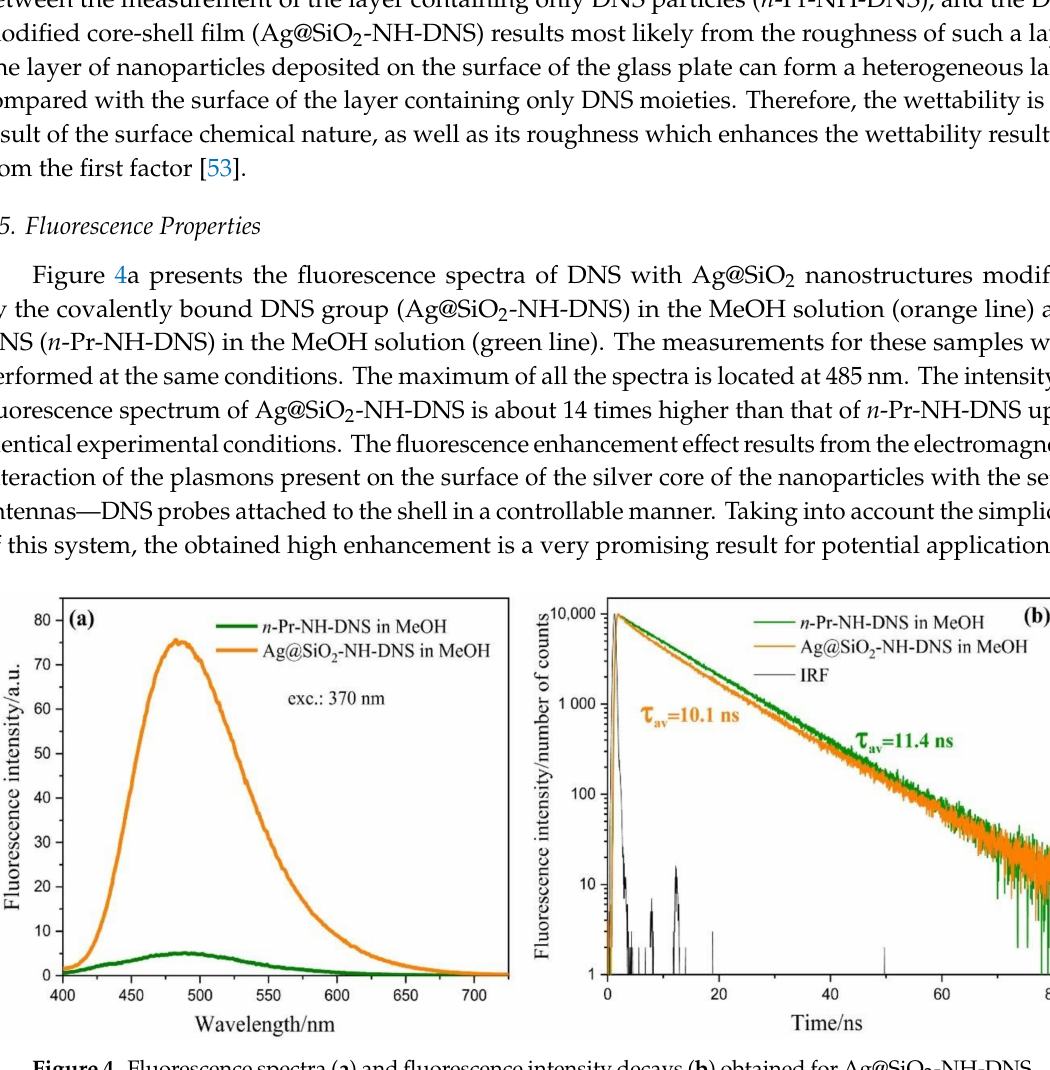
Figure 4. Fluorescence spectra ( a ) and fluorescence intensity decays ( b ) obtained for Ag@SiO 2 -NH-DNS and n -Pr-NH-DNS in the MeOH